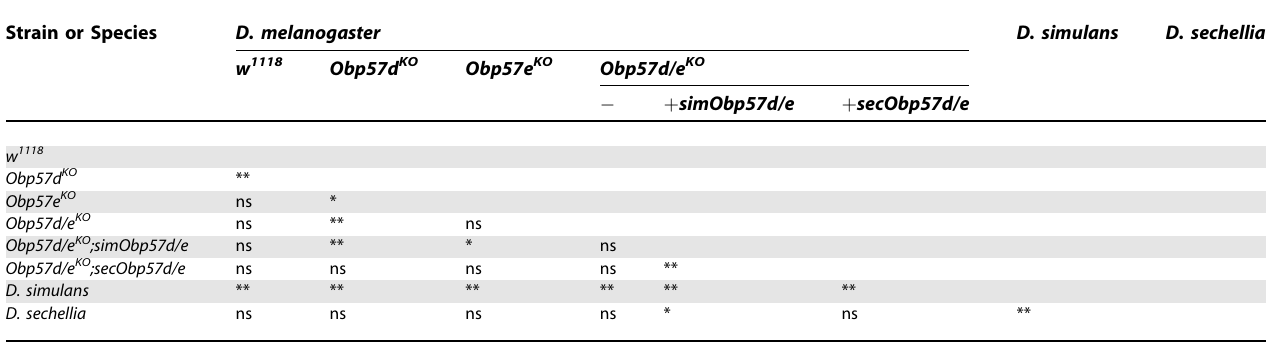
Table 4. Statistical Analysis of Results of Oviposition Site–Preference Assay (Octanoic Acid) Strain or